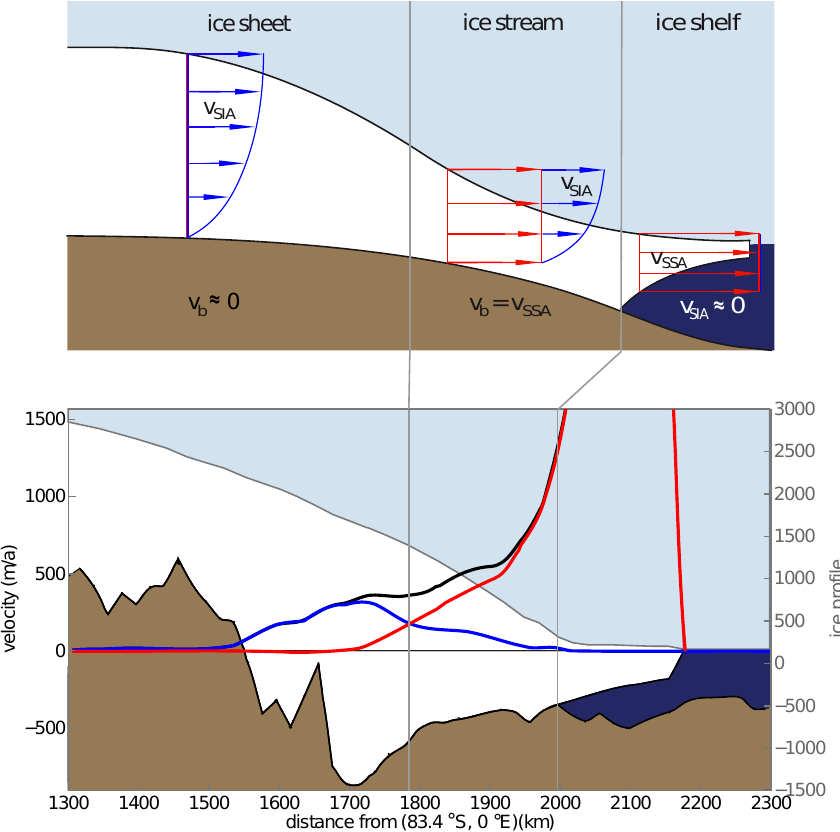
Fig. 1. Superposition of SIA and SSA velocities. Upper panel: schematic diagram of ice profile and different flow regimes. Throughout the grounded ice region, the ice velocity is determined by linear superposition of the SIA (blue arrows) and the SSA velocities (red arrows). Ice sheet with negligible basal sliding. The velocity is dominated by the Shallow Ice Approximation. Friction at the bed leads to shearing in the ice column and a velocity profile as depicted in blue. Ice stream . Both SIA and SSA velocities are relevant for the ice flow. The SSA serves as a sliding law for the shear flow. Ice shelf . The plug flow regime is dominated by the SSA leading to a uniform vertical velocity profile. Lower panel: an example cut through the sheet-stream-shelf transition of Lambert Glacier and Amery Ice Shelf in the equilibrium simulation described in Martin et al. (2011). The model output velocity v = v SIA + v SSA is shown in black. The onset of an ice stream is diagnosed to be where the SSA velocity (red) exceeds the SIA velocity